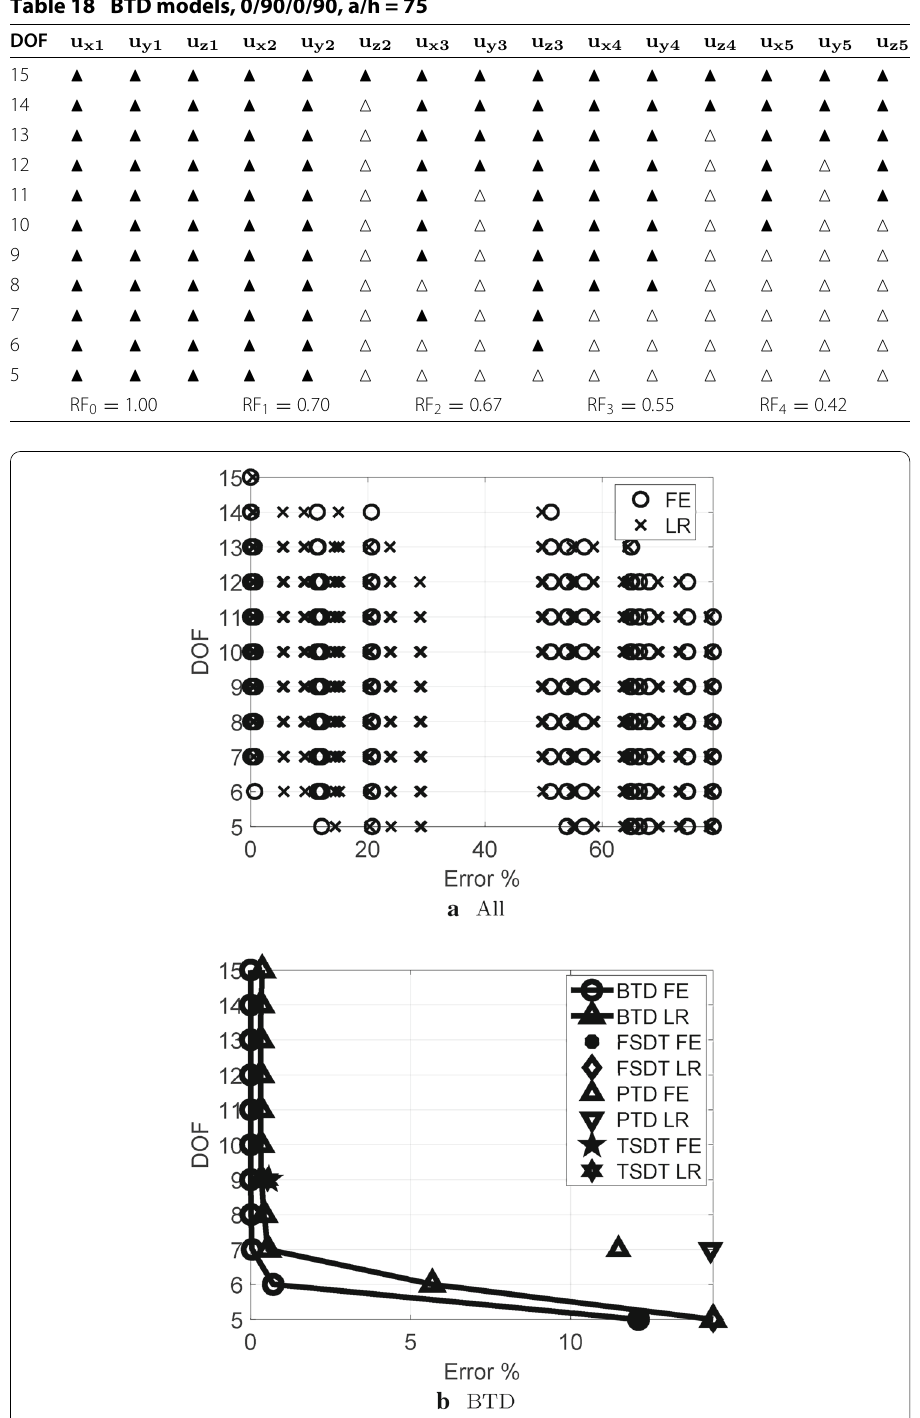
Fig. 12 0/90/0, a/h = 10, comparison between FE and linear regression (LR), 100% training